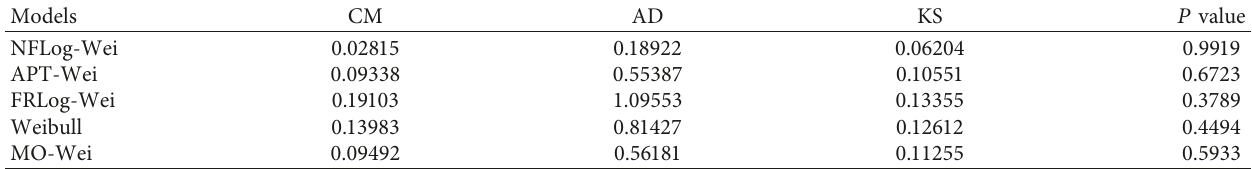
Table 5: The values of CM, AD, KS, and P value of the fitted models for Data 1.